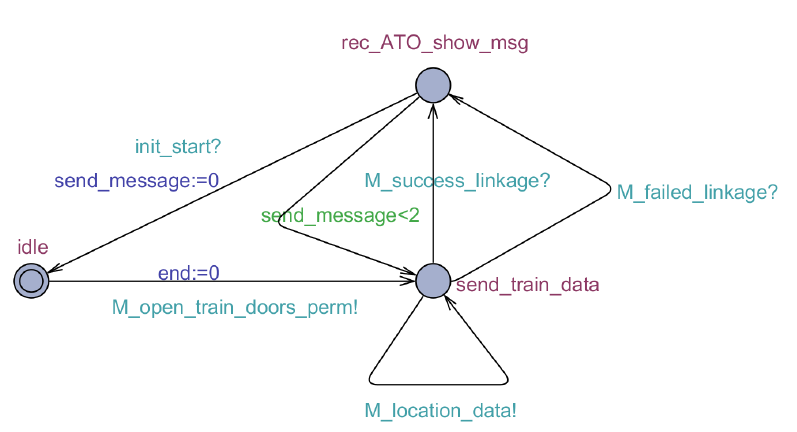
Figure 12. The ATP model of the linkage control scenario of train doors and platform doors.